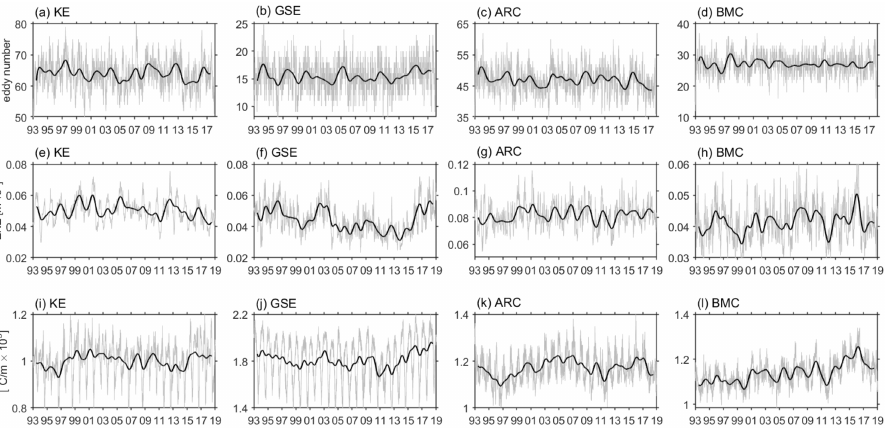
Figure 7. Time series of ( a – d ) eddy numbers, ( e , f ) eddy kinetic energy (EKE), and ( i – l ) background SST gradient in the ( a , e , i ) KE, ( b , f , j ) GSE, ( c , g , k ) ARC, and ( d , h , l ) BMC regions. The thin and thick lines denote the daily and 1.5-year low-pass filtered time series,